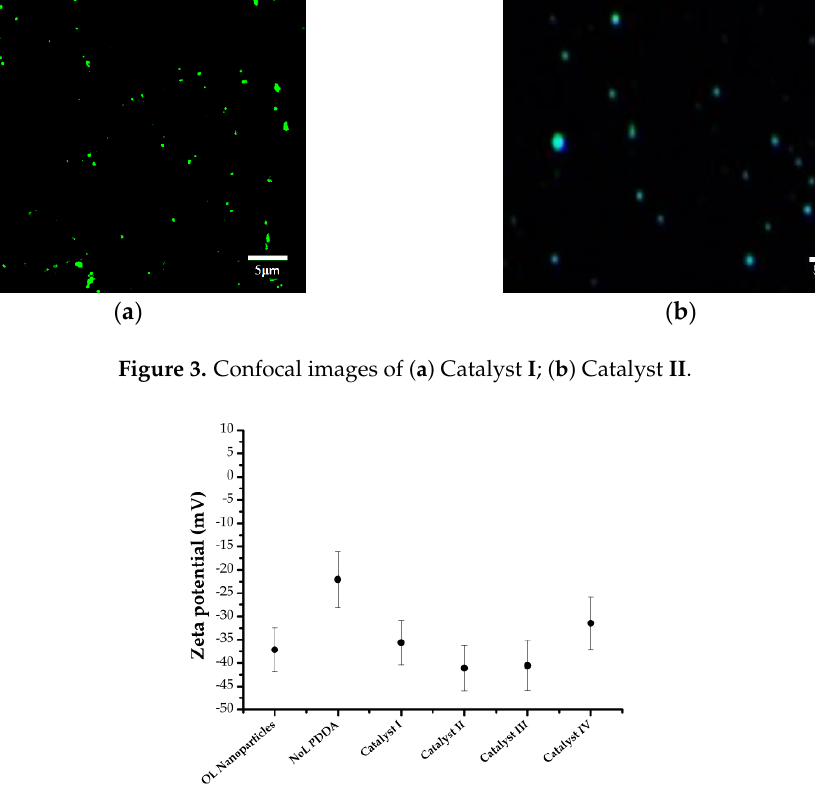
Figure 4. Zeta potential values of OL nanoparticles, OL PDDA nanoparticles, and catalysts I – IV .